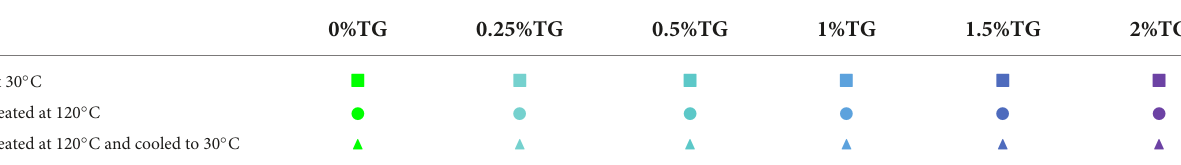
TABLE 2 Color scheme to describe the points of the